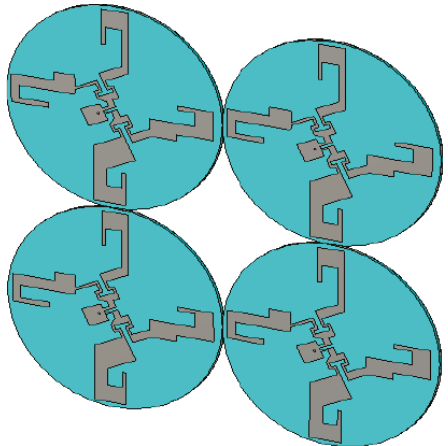
Figure 6: Schematic diagram of a four-antenna array structure.